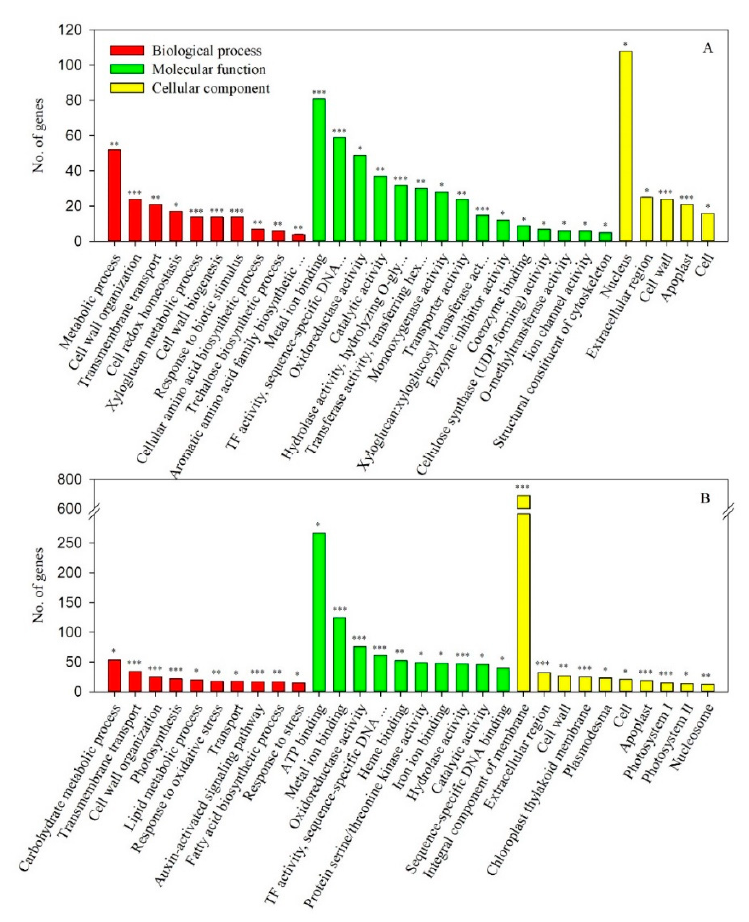
Figure 3. Gene ontology (GO) terms enriched DEGs with a | fold change | > 2 ( p < 0.05) in the ‘Soomee’ peach tree shoots during cold acclimation (CA) ( A ) and deacclimation (DA) ( B ). GO terms were classified into biological process, molecular function, and cellular component categories. Fold changes were determined based on the FPKM values at late CA and late DA as compared to those at early and late CA, respectively. Asterisks (*, **, ***) on the bars indicate significance using the modified Fisher’s exact test at p < 0.05, 0.01, or 0.001, respectively. The significantly overrepresented DEGs included in each GO term are listed in Table S1.